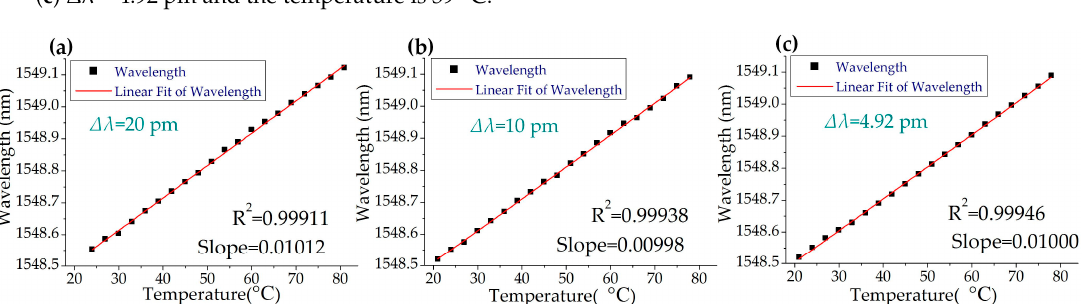
Figure 6. Interrogating results of FBG temperature sensing. ( a ) ∆λ = 20 pm. ( b ) ∆λ = 10 pm. ( c ) ∆λ = 4.92 pm.